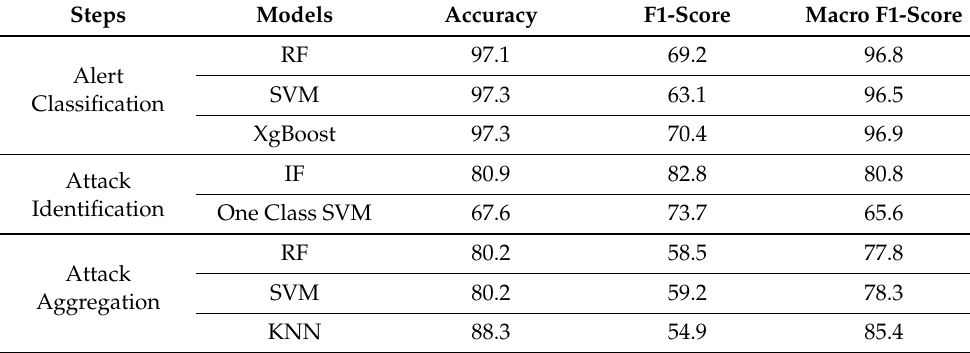
Table 4. Incident Response Experiment